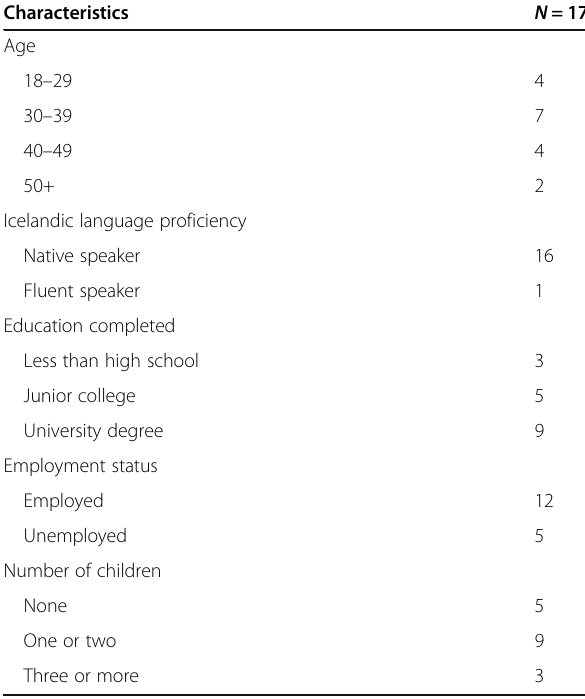
Table 2 Overview of the participants ’